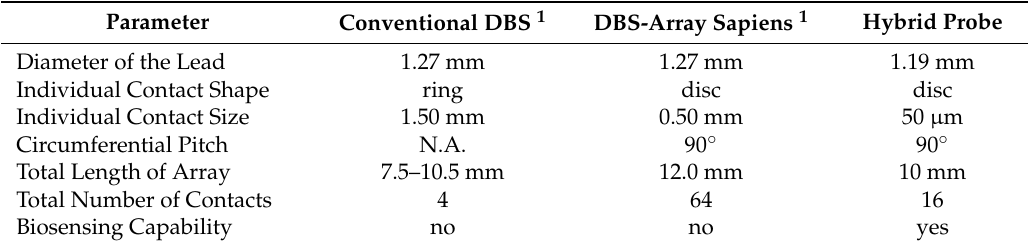
Table 1. Comparison of the DBS lead